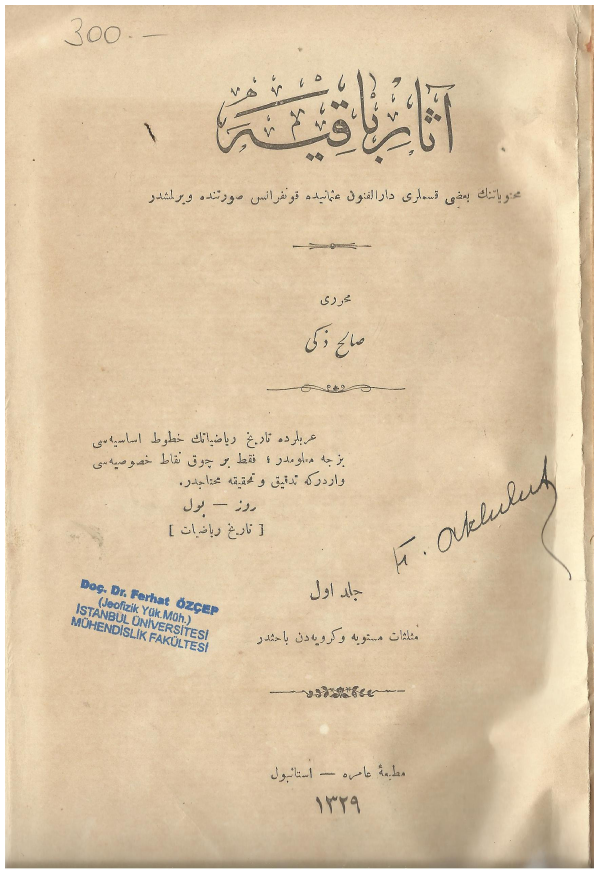
Figure 3c. Cover page of Hikmet-i Tabiye (Physics or Natural Phi- losophy) written by Salih Zeki in 1900 (from my own library).